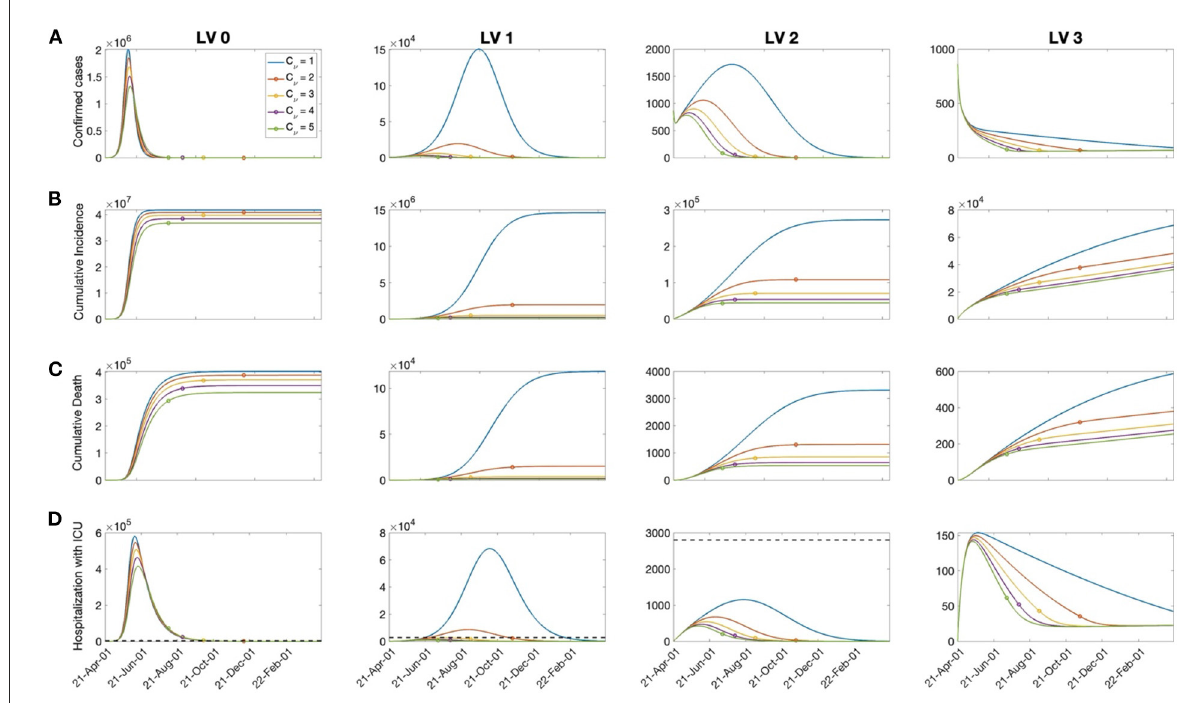
FIGURE3 The effects of vaccination on: (A) Confirmed cases, (B) cumulative confirmed cases, (C) death, and (D) hospitalized population in the ICU for C ν = 1,2, ··· , 5 and the SD level 0, 1, 2, 3. The dashed line in the bottom panels represents the capacity of ICU bed for COVID-19 patients in Korea. The circle on each curve represents the time at which the vaccination coverage rate reaches